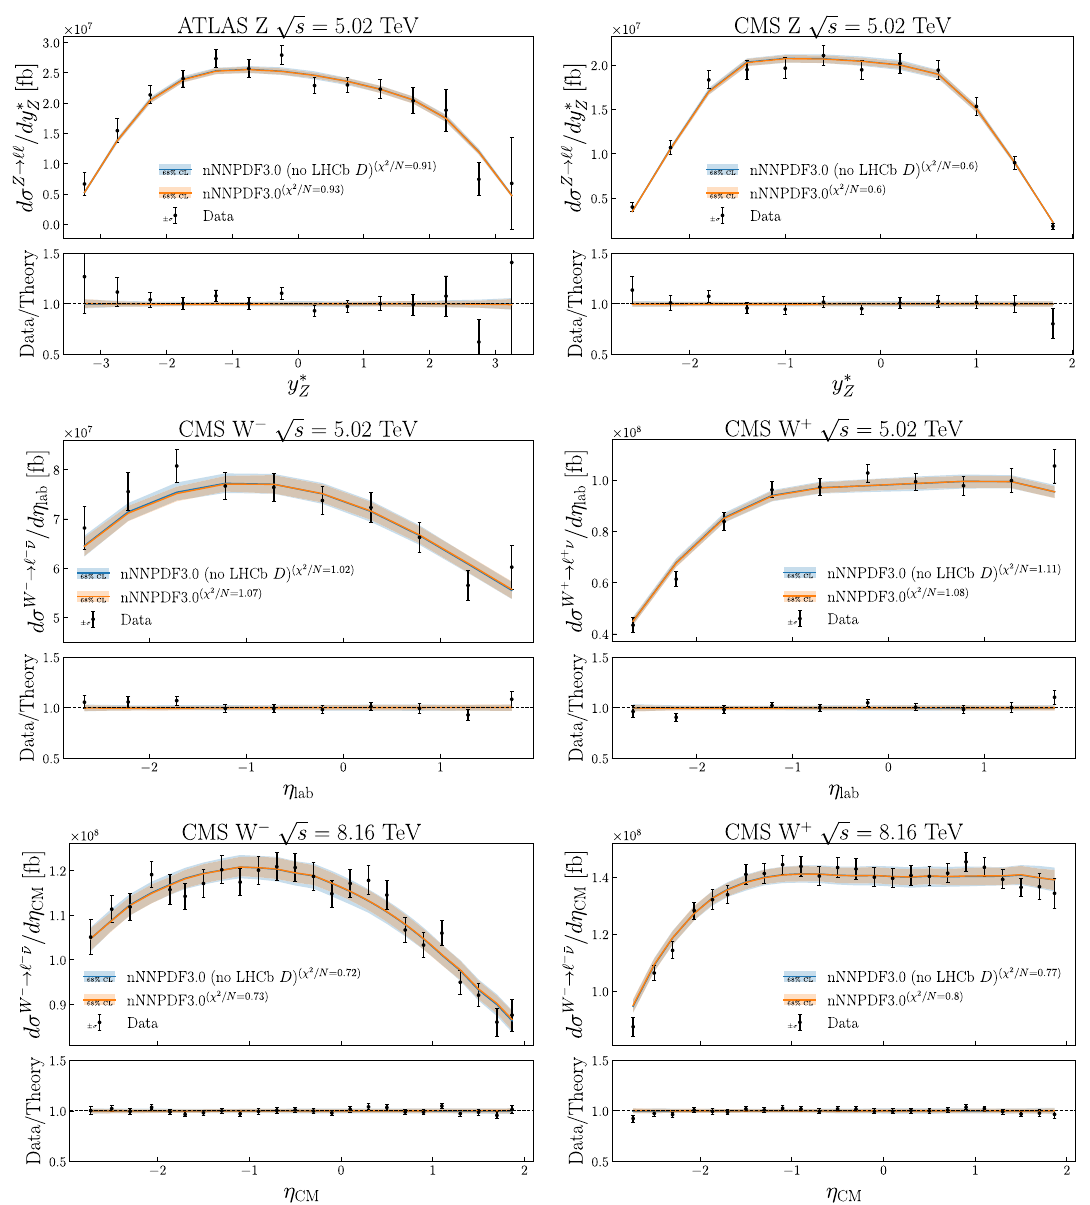
Fig. 32 Same as Fig. 31 for LHC datasets on gauge boson production in pPb collisions, specifically for the ATLAS and CMS Z production measurements at 5.02 TeV, and the charged lepton rapidity distributions for W + and W − collisions from CMS at 5.02 TeV and 8.16